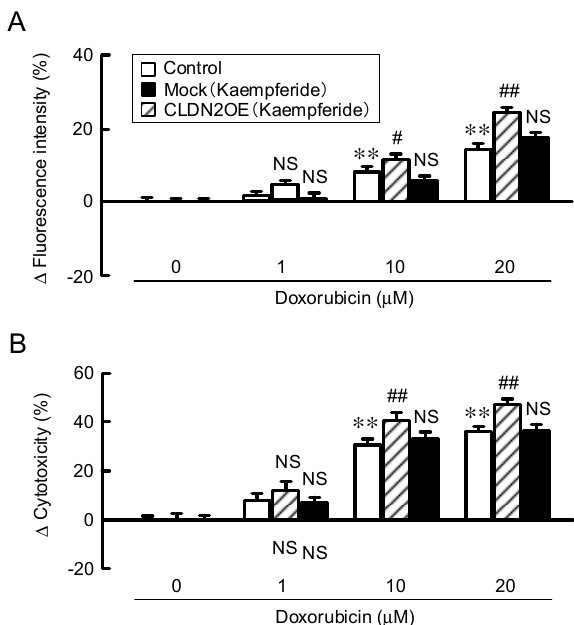
Figure 10. Elevation of chemoresistance by overexpression of CLDN2. ( A ) The spheroid cells were transfected with mock or CLDN2 expression vector followed by incubation with 10 µ M kaempferide for 24 h. ( A ) The cells were incubation with doxorubicin for 60 min. The fluorescence intensity of doxorubicin in the spheroids was examined using a BZ-X800 fluorescence microscopy. ( B ) Cell viability was measured using a CellTiter-Glo 3D Cell Viability Assay kit. The fluorescence intensity of doxorubicin and cell viability are represented as a percentage relative to 0 µ M doxorubicin. n = 5–8. ** p < 0.01 compared with 0 µ M doxorubicin. ## p < 0.01, # p < 0.05, and NS p > 0.05 compared with control (Two-way analysis). Fluorescence intensity (F 2,59 = 22.07, p < 0.0001) and cytotoxicity (F 2,47 = 42.71, p < 0.0001).